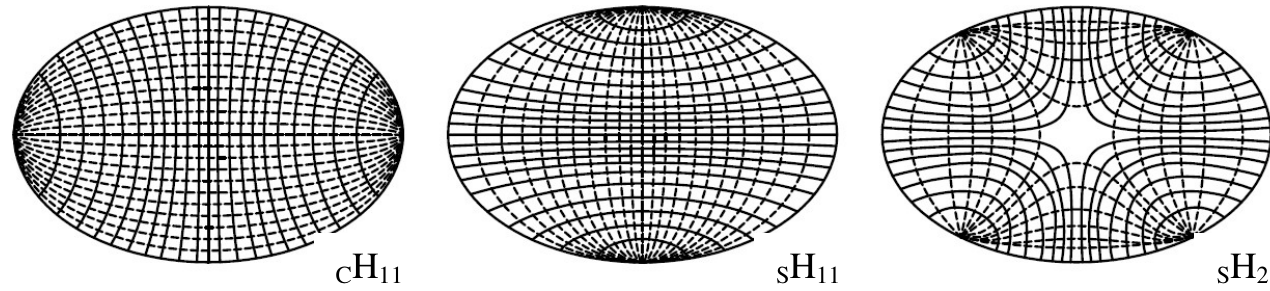
FIG. 8. Field patterns (electric—solid line, magnetic—dashed line) for